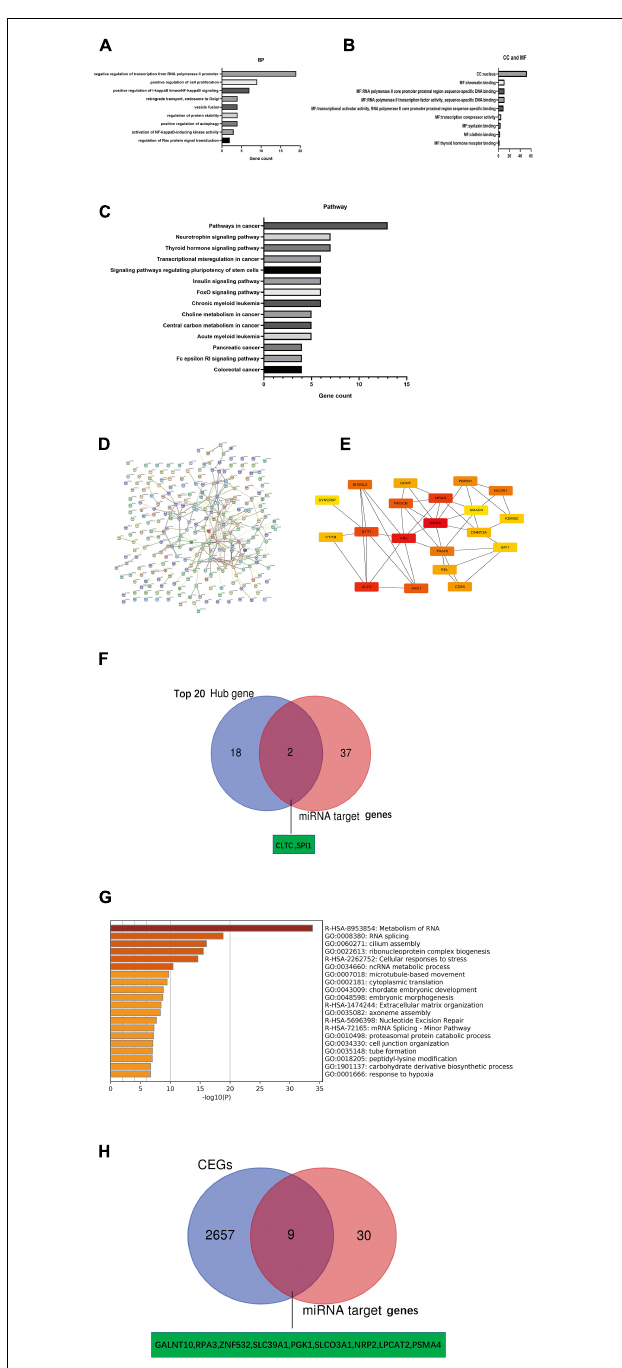
FIGURE 7 | Identification of key mRNA genes in PDAC by hub gene screening and Co-lncRNA analysis. (A–C) GO functional annotation and KEGG pathway enrichment analysis for the potential target genes of miRNAs by TargetScan 7.2. (D,E) Top 20 hub genes identified in protein-protein interaction (PPI) networks. (F) Intersection of the top 20 hub genes and 39 miRNA target genes by Venn analysis. (G) Bar graph of enriched terms across input gene lists [2,666 coexpressed protein-coding genes (CEGs) of NR2F1-AS1], colored by p -values from Metascape. (H) Intersection of 2666 coexpressed protein-coding genes (CEGs) of NR2F1-AS1 from Co-lncRNA and 39 miRNA target genes by Venn